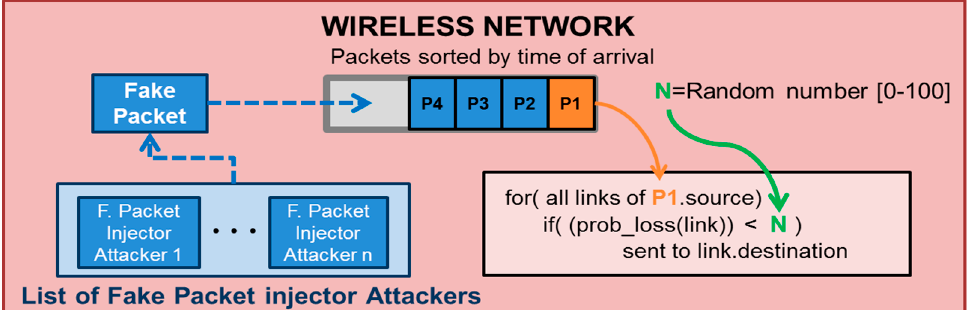
Figure 7. Simulation with Fake Packet Injection attackers.